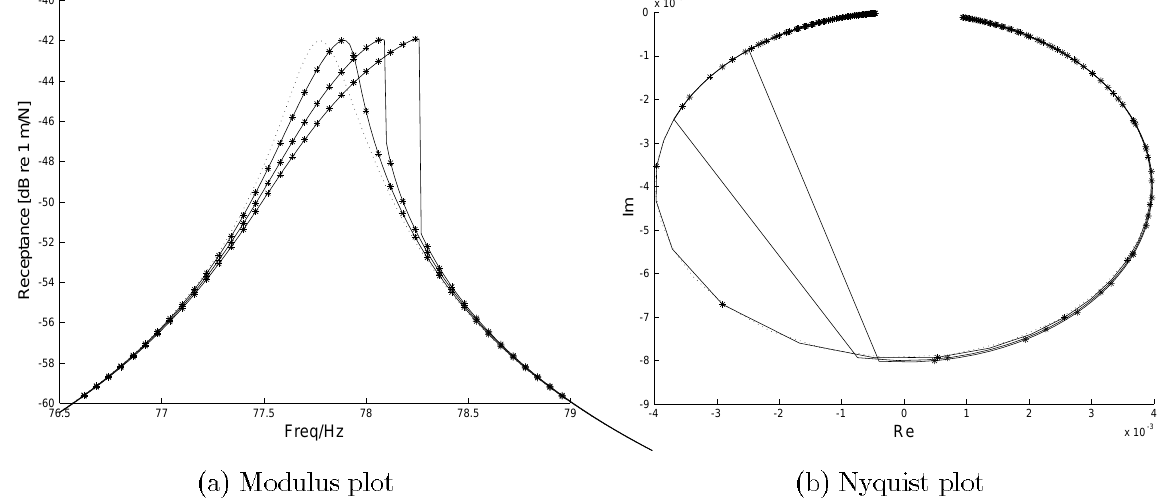
Fig. 4. Response predictions with different force levels: ... Linear FRF, HBM simulation, ∗ ∗ ∗ Regenerated using modal parameters.